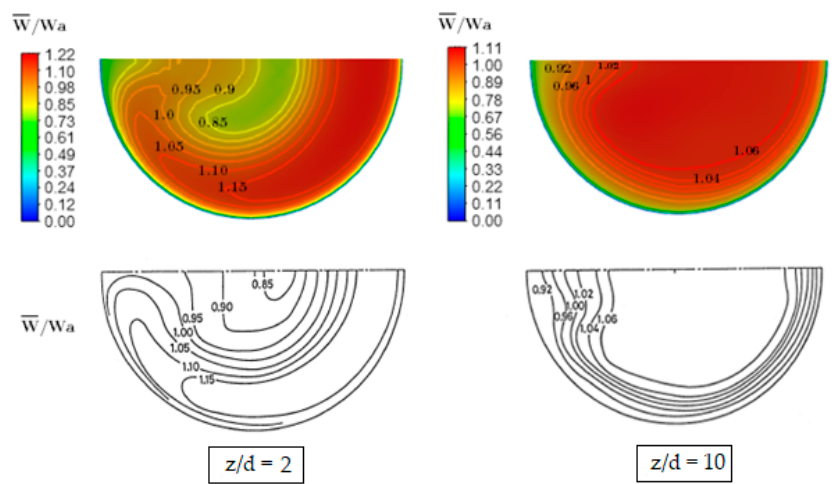
Figure 4. Flow velocities in cross section z/D = − 1, ϕ = 0 ◦ , ϕ = 30 ◦ , ϕ = 60 ◦ , ϕ = 90 ◦ , z/D = 2 and z/D = 10. Figures above in color represent the results obtained with the RNG k - ε model, where the numerical values are normalized by the axial velocity of the flow, W/Wa. The lower figures (in black) are the velocity contours given [10]. For each figure, the left side represents the inner area of the curve and the right side the outer area.